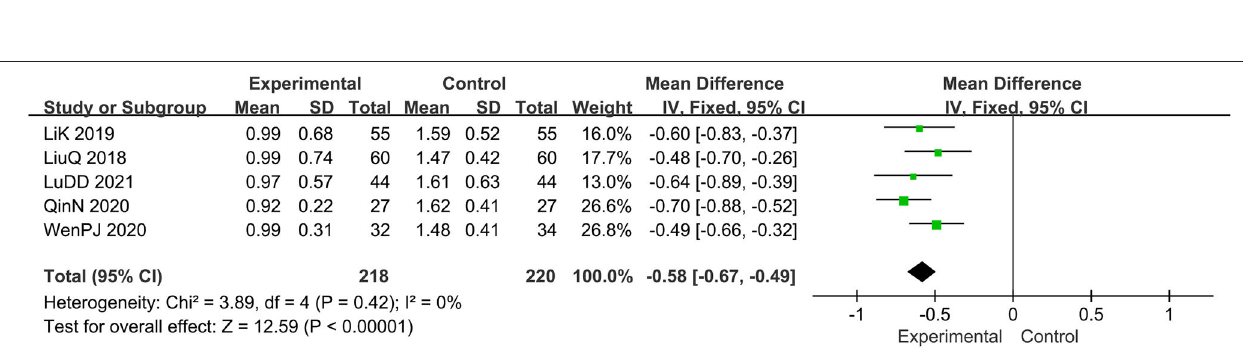
= 0.43). Results showed that relative to the prednisone